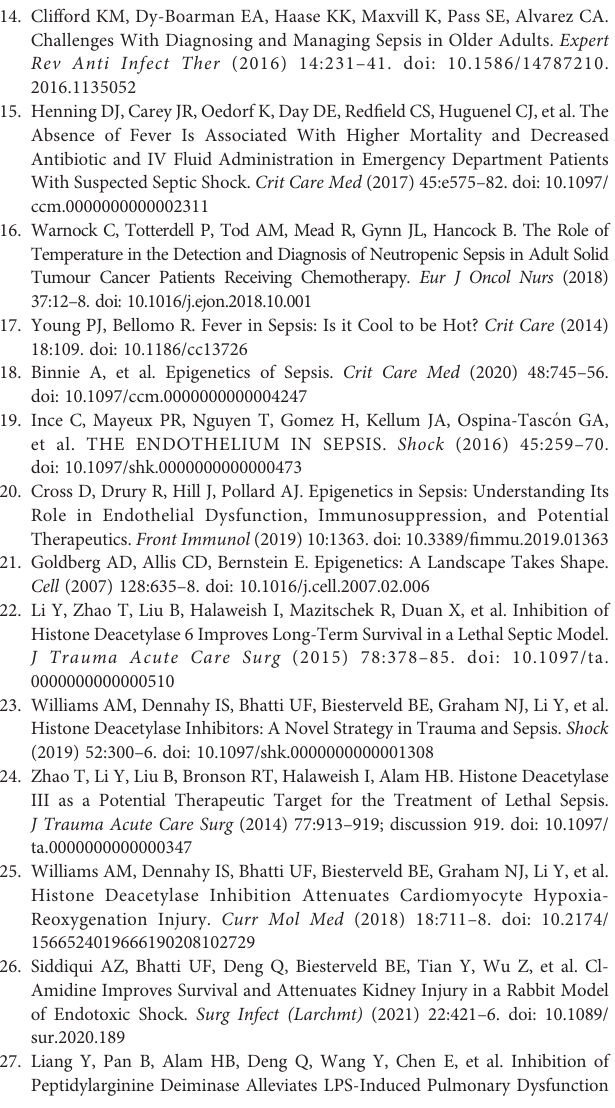
Supplementary Figure 1 | ROC curve of H3K18la for diagnosis septic shock patients from non-septic shock patients. The area under the ROC curve (AUC)